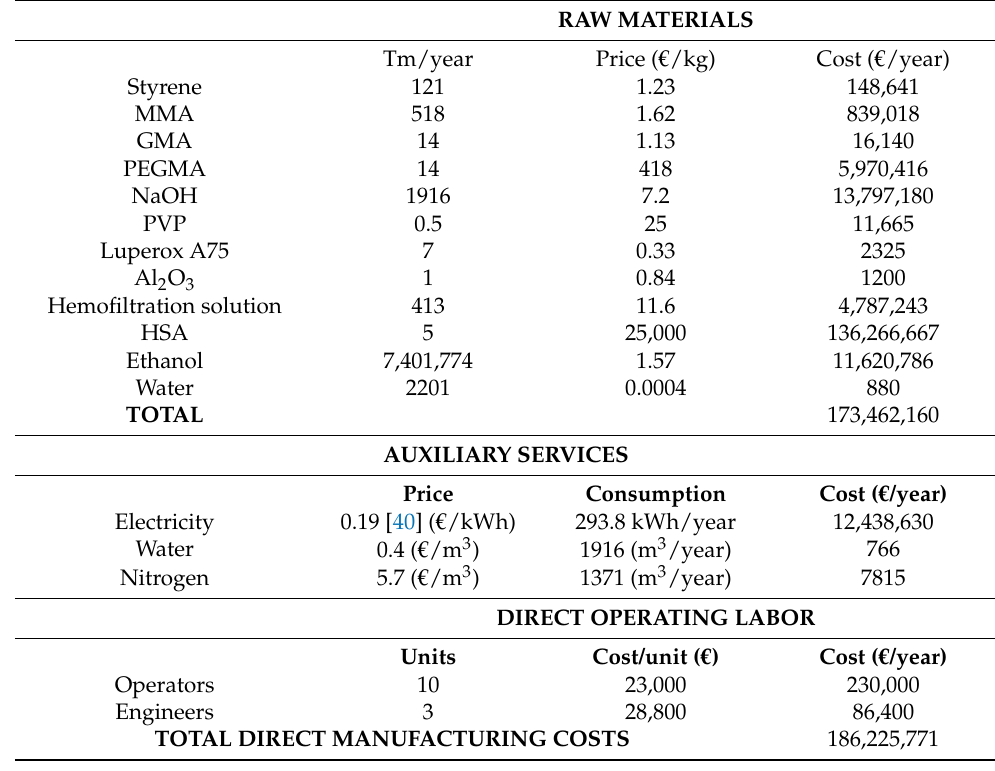
Table 10. Direct manufacturing costs.